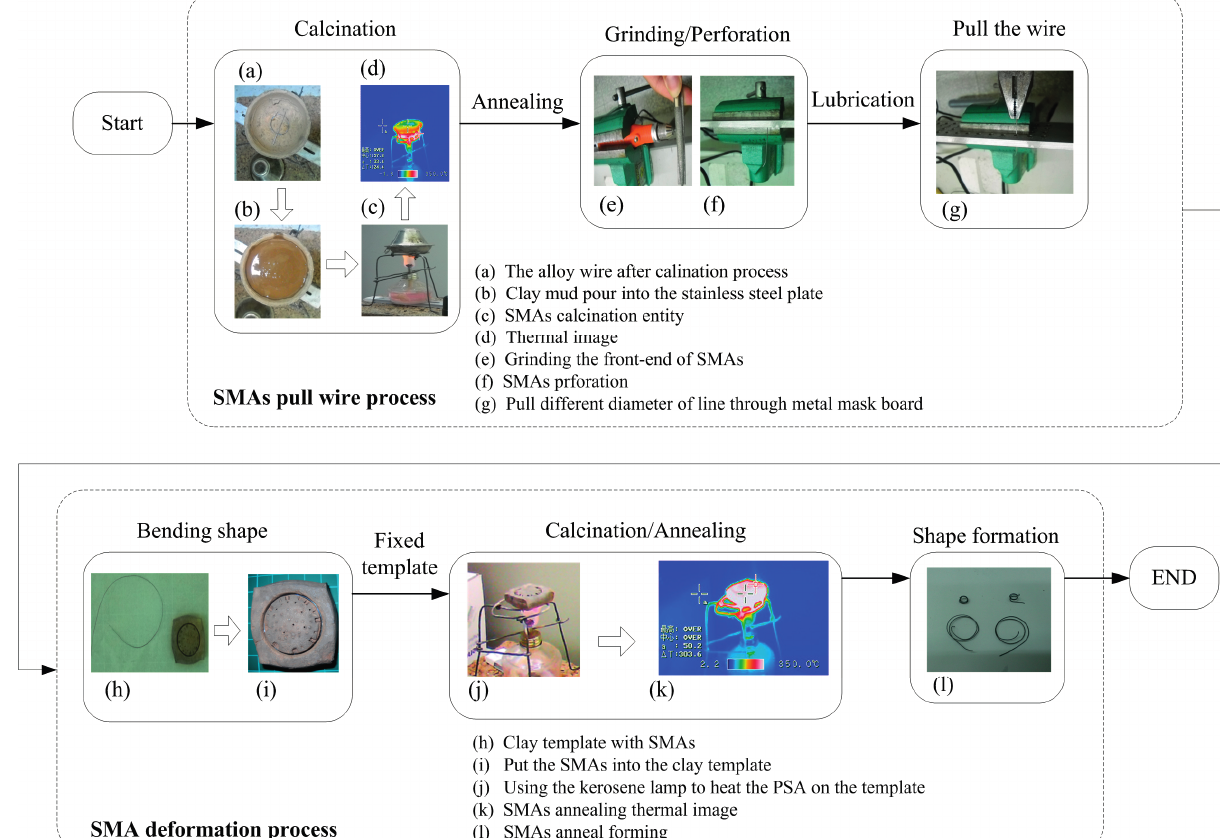
Figure 7. SMA processing and memory process.